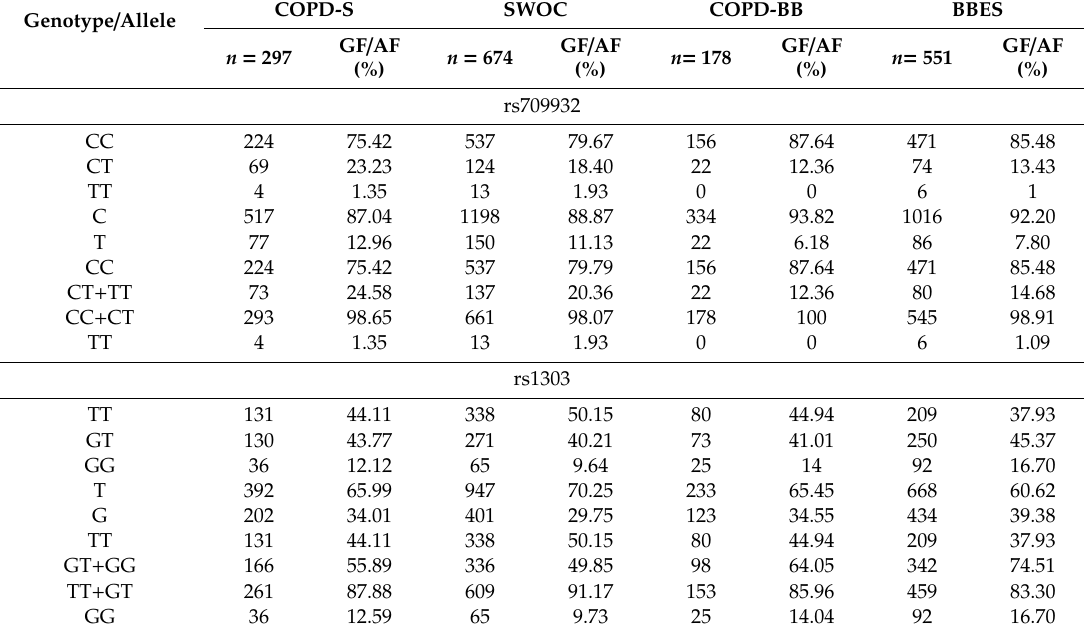
Table 3. Allele and genotype frequencies of SERPINA1 single nucleotide polymorphisms (SNPs)